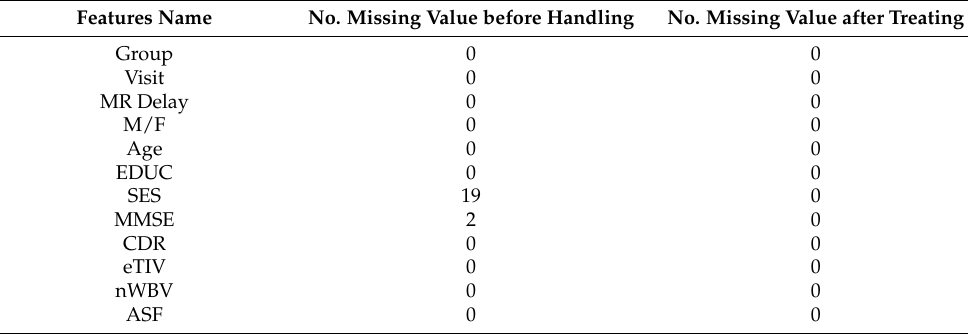
Table 2. The processing of missing